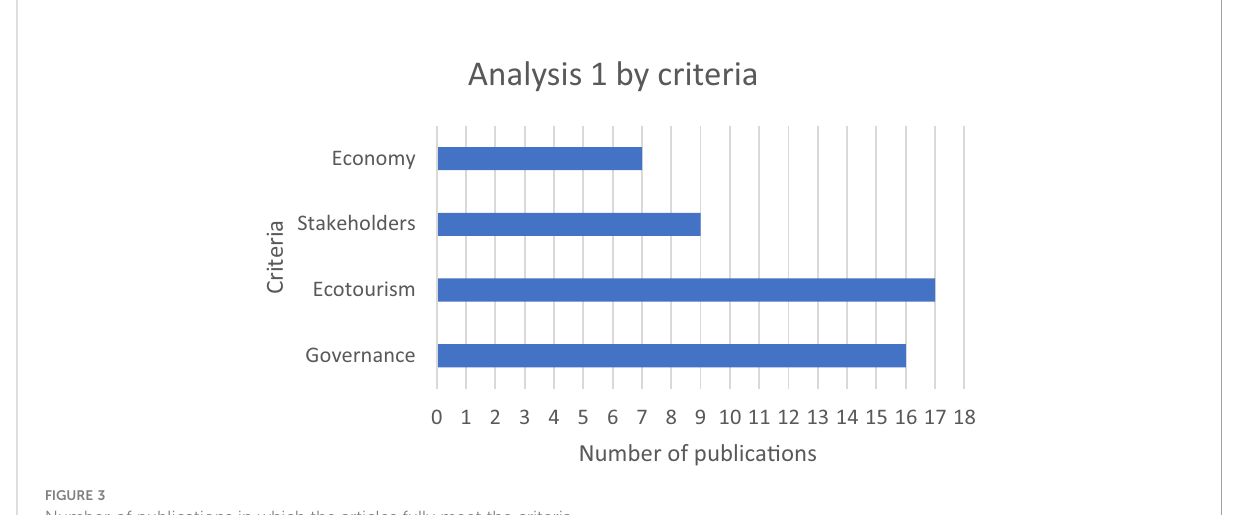
FIGURE 3 Number of publications in which the articles fully meet the